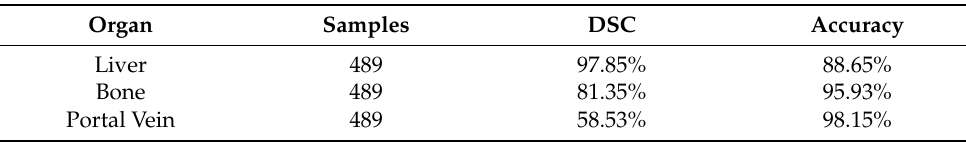
Table 1. Performance comparison results on the test set.